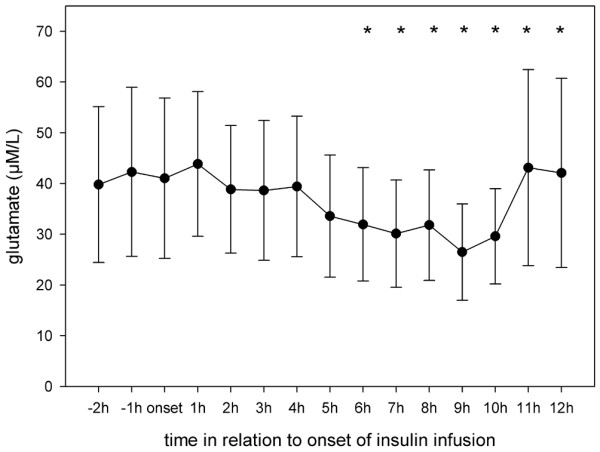
Course of cerebral extracellular glutamate during insulin infusion. Data are expressed as mean ± standard error of hourly microdialysate concentrations from 24 patients treated with continuous intravenous insulin. Levels of significance are indicated for comparison with microdialysate concentrations at onset of insulin infusion (Wilcoxon signed-rank test). *P < 0.05